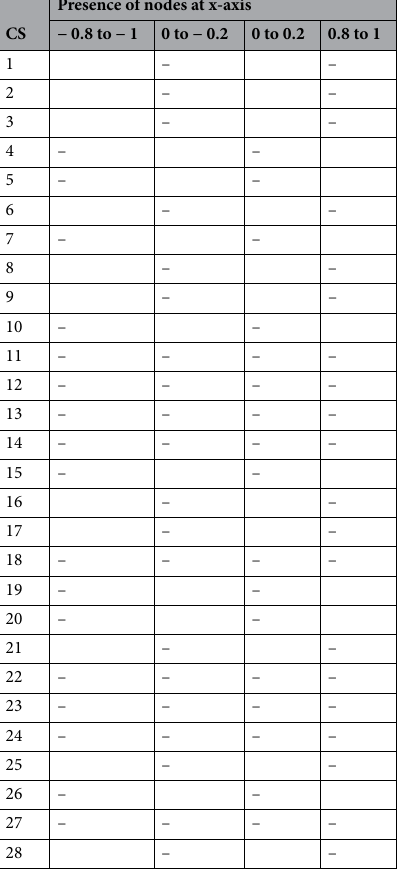
Table 1. The clustering of nodes of counterfeit sample (CS) of RM50.